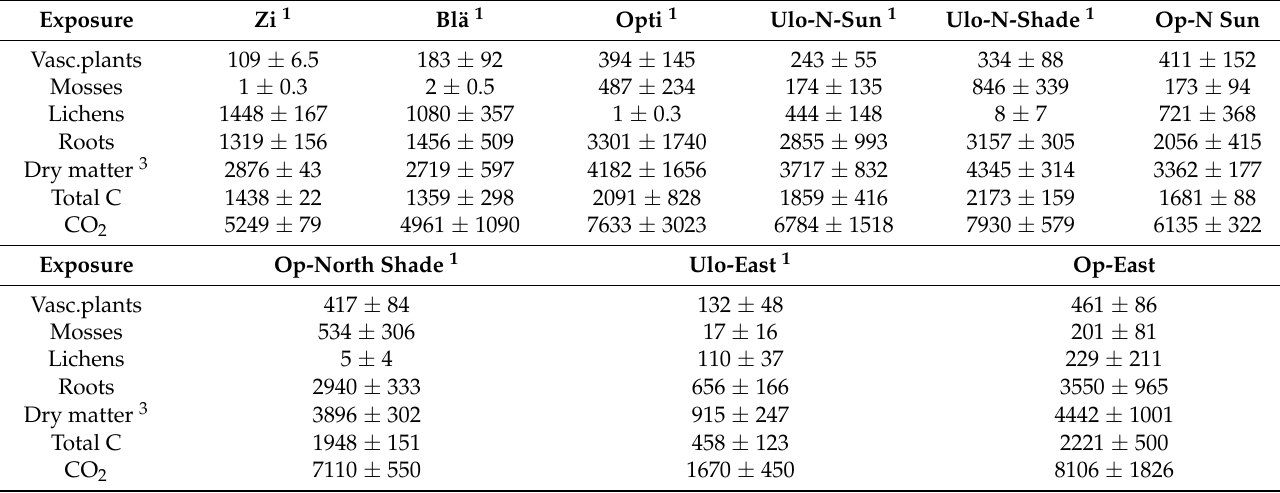
Table 7. Examples of the harvested dry phytomass in g/m 2 with SD from various media with 10-cm depth. Calculation for 1 m 2 ; analysis based on the mean of 3 harvesting plots each.